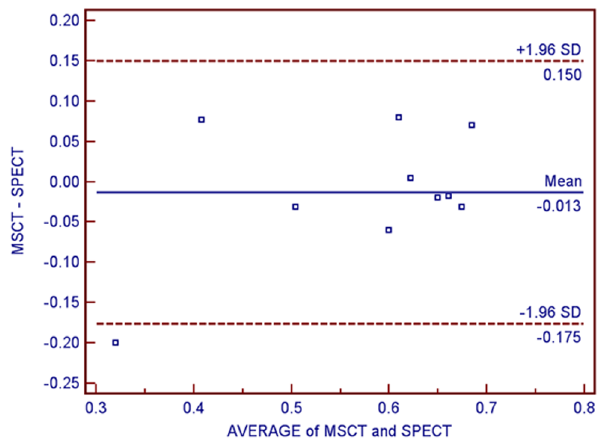
Figure 2. Bland-Altman Plots of Left Ventricular Ejection Fraction using Multislice Computed Tomography (MSCT) and Single-photon Emission Computed Tomography (SPECT).